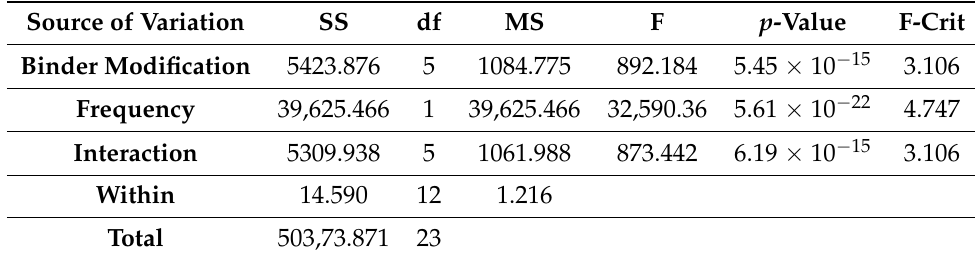
Table 10. Two-way ANOVA testing of the rutting parameters versus